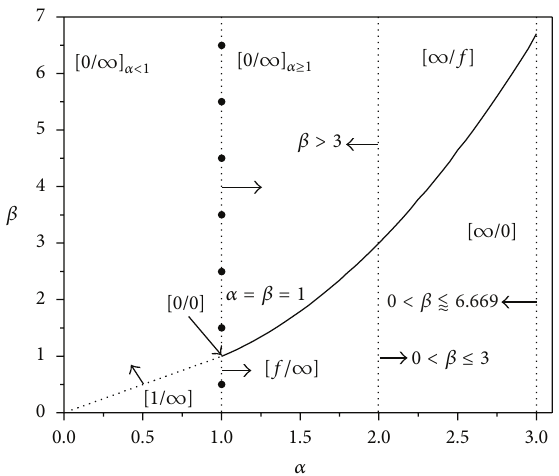
Figure 1: 𝛼 - 𝛽 phase diagram for 𝐸 𝛼,𝛽 (𝑧) . The arrows point to the particular phase into which a Mittag-Leffler function whose parameters lie on a phase boundary belongs. Dotted lines are used to indicate phase boundaries where 𝛼 and 𝛽 are known exactly and solid lines for boundaries where 𝛼 and/or 𝛽 may be determined as accurately as desired but not known exactly. In opposition to the remainder of the points on the line 𝛼 = 1 , the dark points at 𝛽 = 1/2 to 𝛽 = 3/2, 5/2, 7/2, 9/2, .. . belong to phase [0/∞] 𝛼<1 and phase [ 1/∞